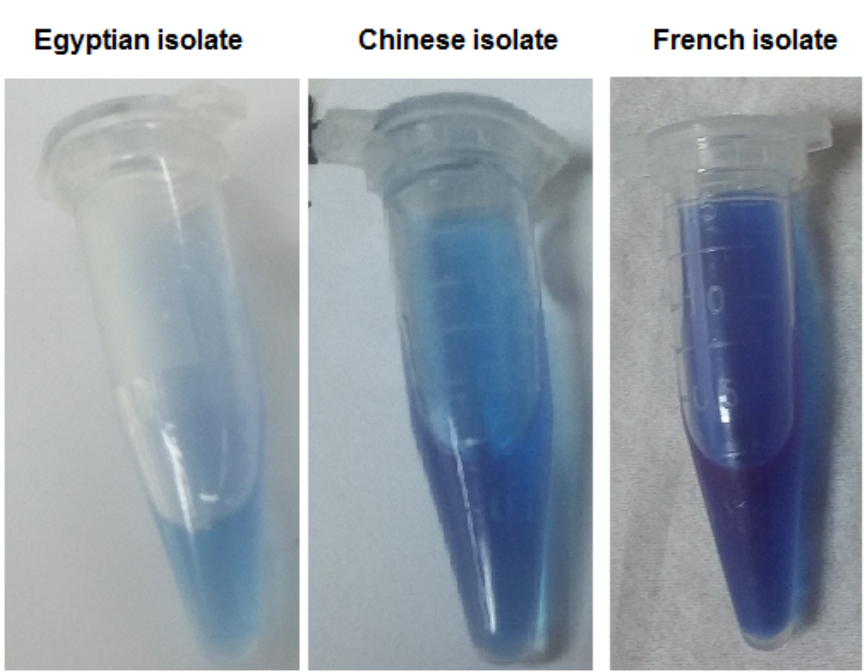
Figure 2. Extracted C-phycocyanin from dry biomass of the three microalgae strains.